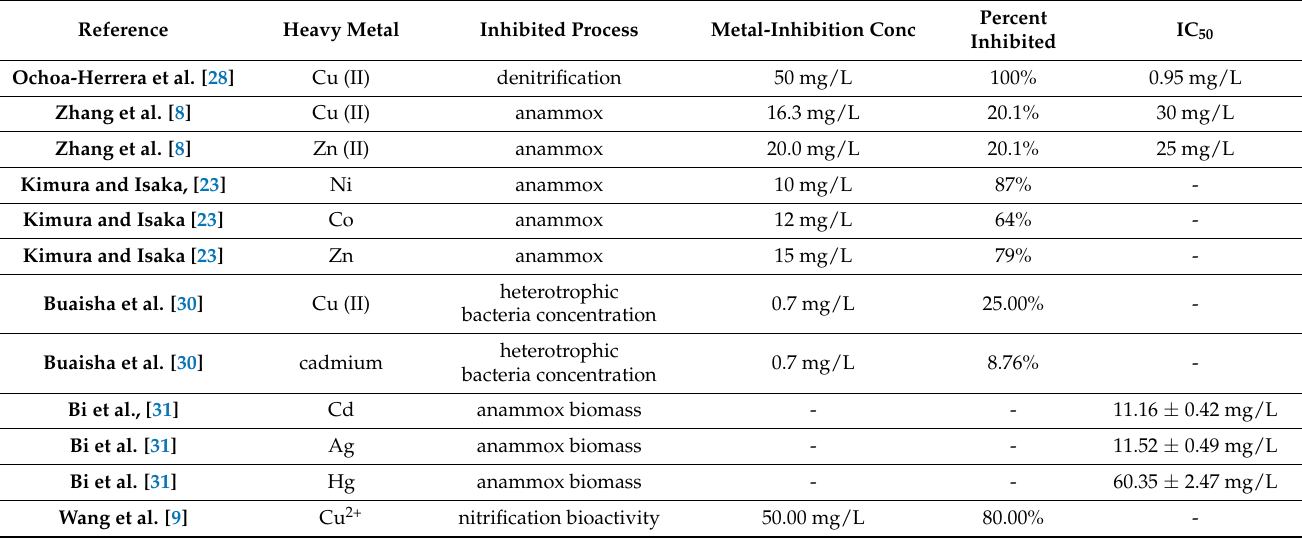
Table 1. Heavy metals and their inhibition effect on wastewater treatment biological